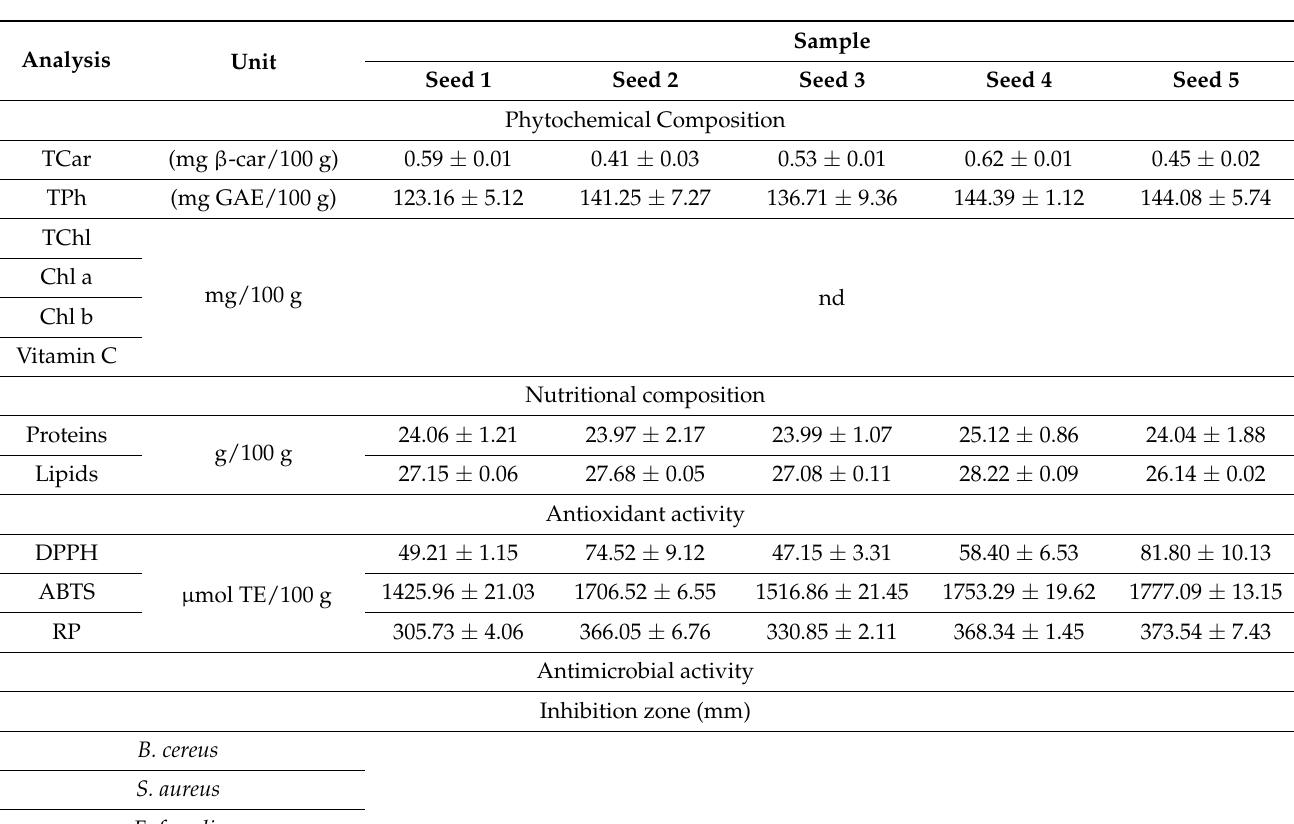
Table 3. The obtained results for seed